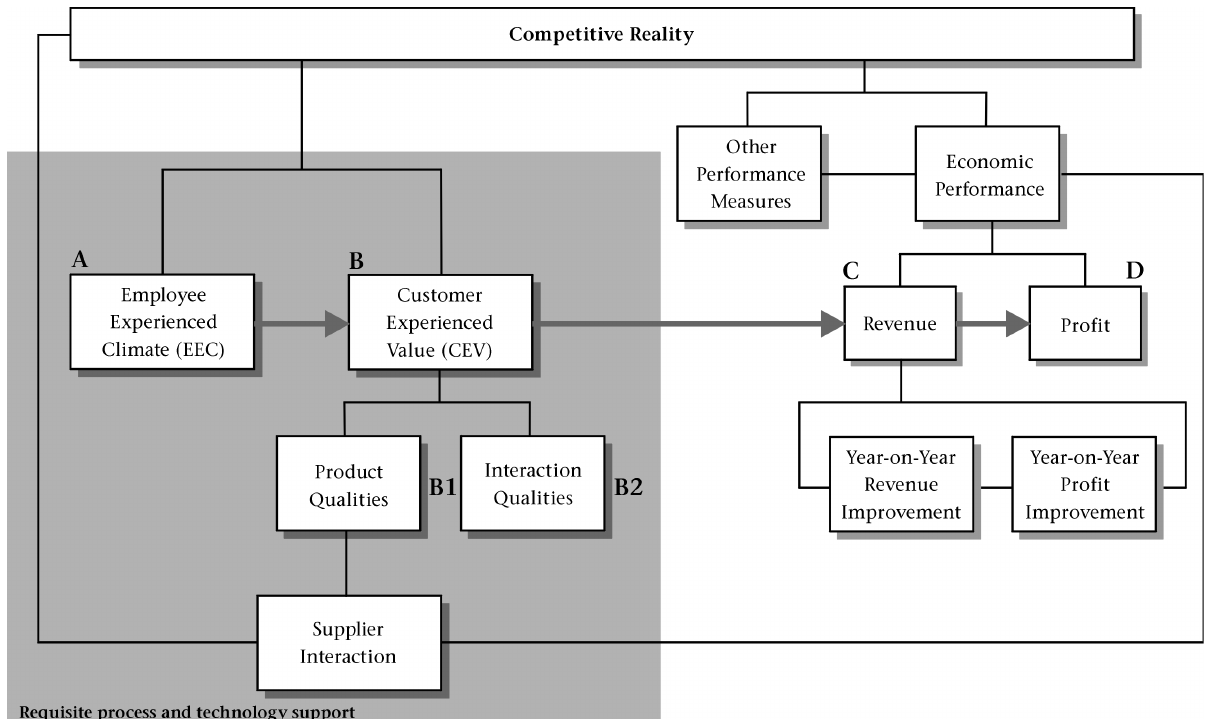
Figure 2: A model of employee- and customer-based sustainable